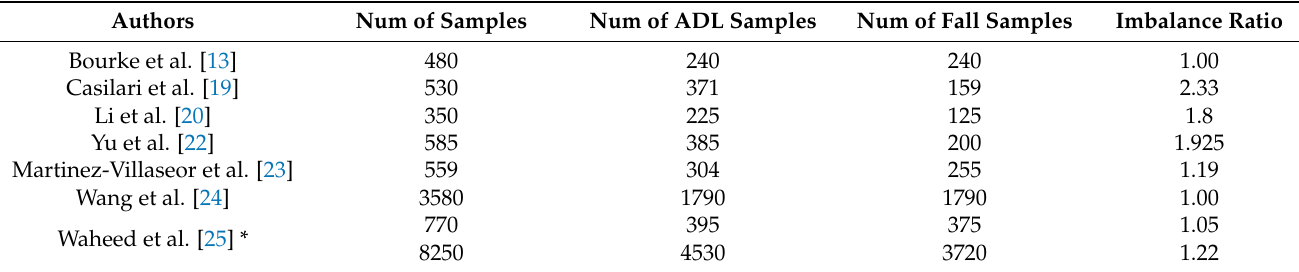
Table 1. Comparison of imbalance ratio in previous